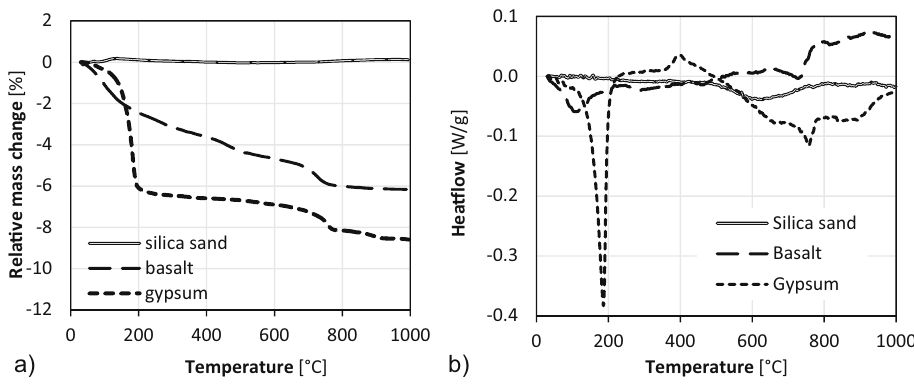
Figure 3: Thermal analysis of raw materials. ( a ) TG and ( b ) DSC curves.